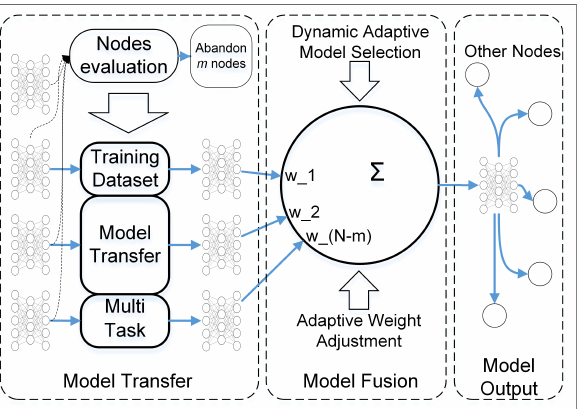
Figure 2. Information process in a single node with three main segments: model transfer, model fusion, and model output.